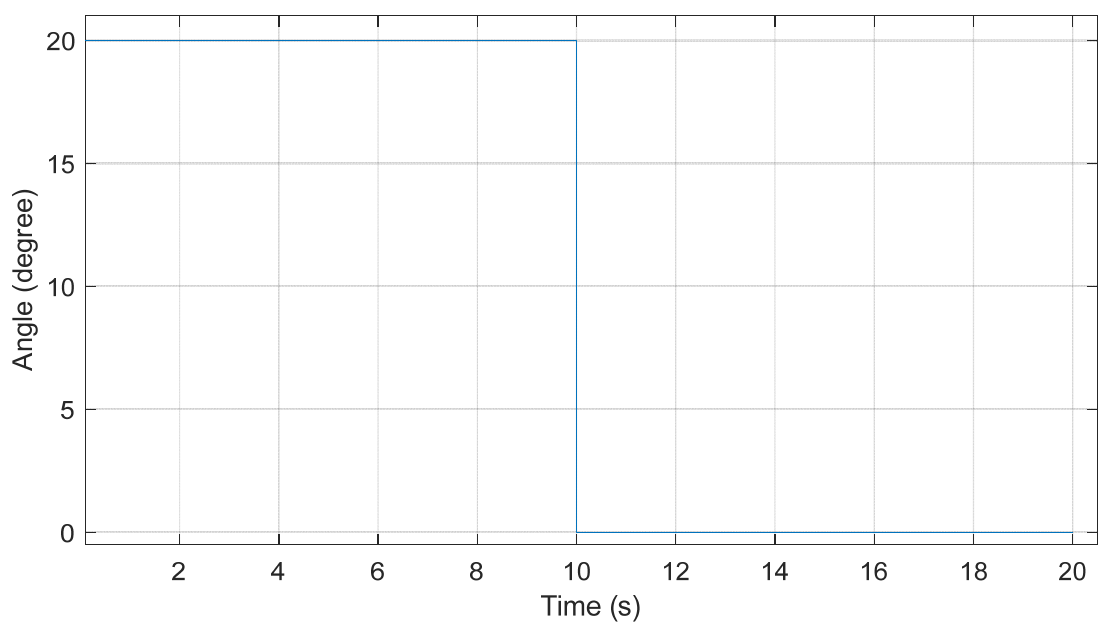
Figure 2. Desired input angles of the manipulator. Table 1. parameter specifications for the flexible manipulator.